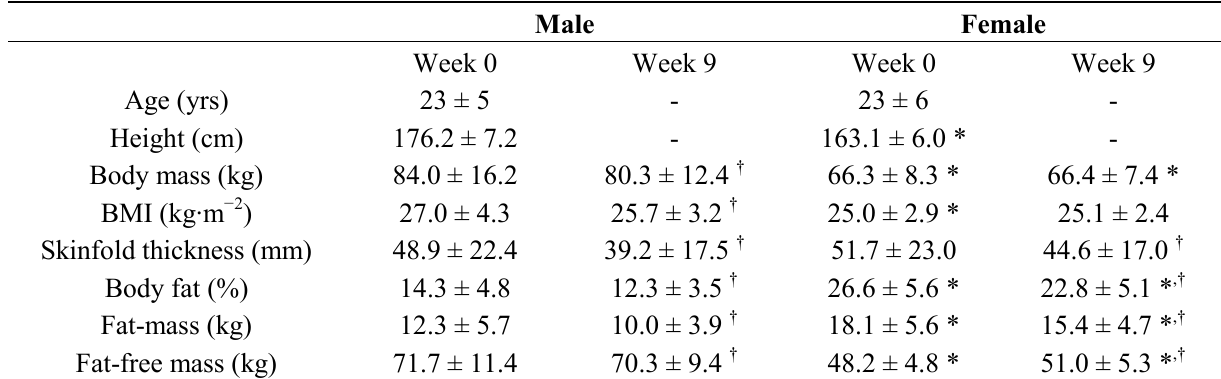
Table 1. Alterations in body composition 1,2 .